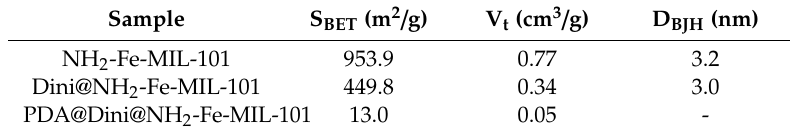
Figure 7. The curves of Dini release from Dini@NH 2 -Fe-MIL-101 ( a ) and PDA@Dini@NH 2 -Fe-MIL-101 ( b ) at different pH values of 3.1, 7.0 and 10.3. Error bars correspond to standard errors of triplicate measurements.